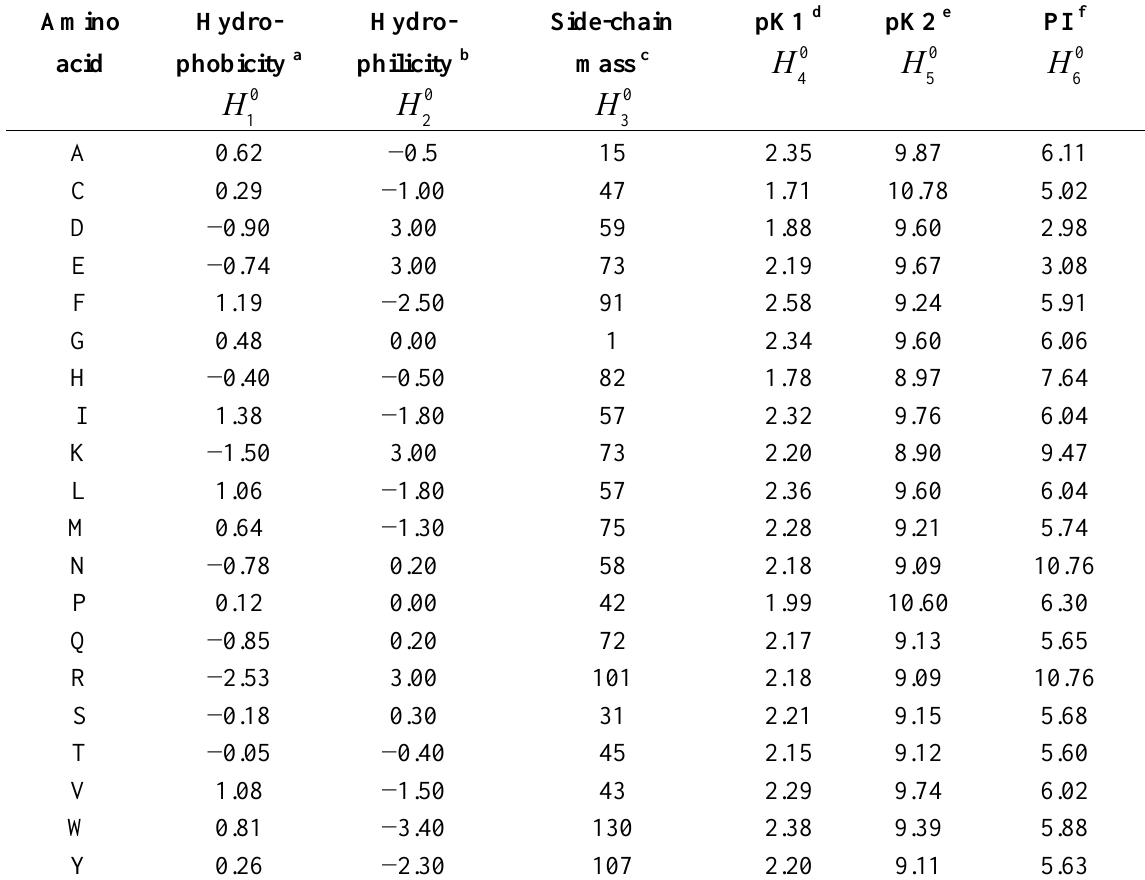
Table 2. List of the original values of the six physical-chemical properties for each of the 20 native amino